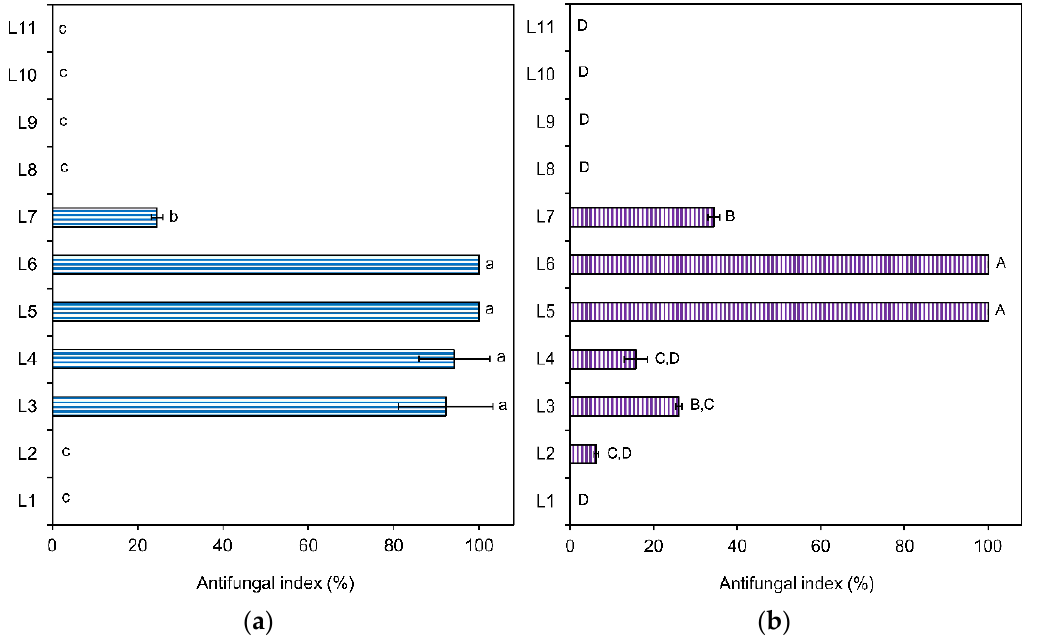
Figure 1. Antifungal activities of 11 fractions from leaf essential oil against wood-rotting fungi at a concentration of 200 μg/mL. ( a ) L. sulphureus ; ( b ) L. betulina . Different letters ( a – c; A – D ) in the Figure are statistically different at p < 0.05 according to the Scheffe test.